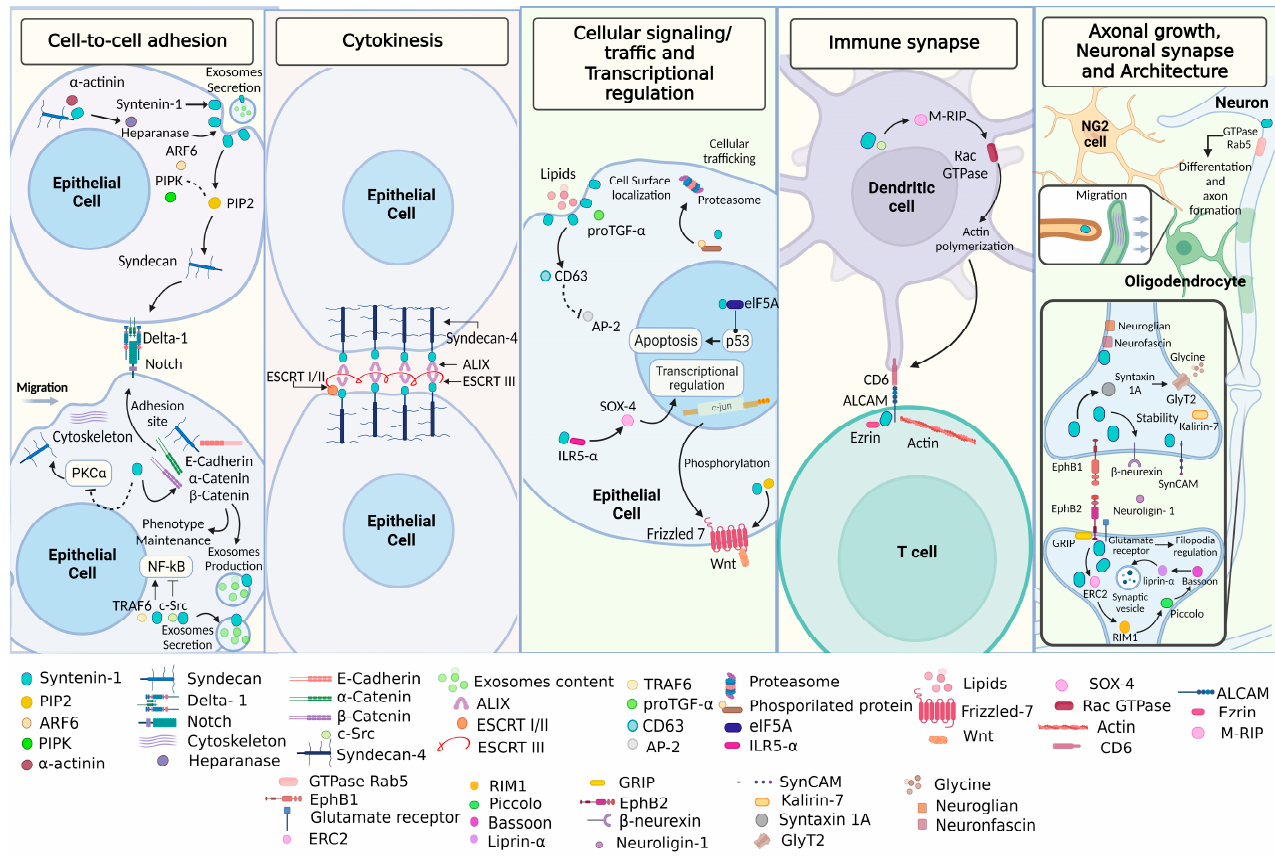
Figure 2. Biological functions of syntenin-1 . The expression of syntenin-1 allows cell-to-cell adhesion by the interaction with molecules such as Delta-1, E-cadherin, TRAF6, and PIP2. Syntenin-1 participates in the signaling and cellular traffic, along with proTGF- α . For transcriptional regulation, syntenin-1 interacts with Frizzled-7, PIP2, IL5RA, and Wnt, whereas, for cytokinesis, interacts with molecules such as ALIX and syndecans. During the immune synapse, syntenin-1 relates with ALCAM and ezrin; finally, in the neuronal synapse, syntenin-1 interacts with neurexin, neurofascin, GlyT2, glutamate receptors, and beta Ephrin. Image created in BioRender (www.biorender.com, accessed on 14 February 2023).